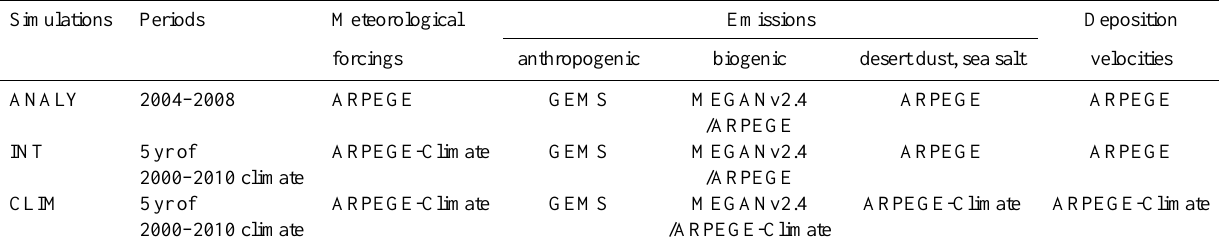
Table 1. Simulations considered for the present study.